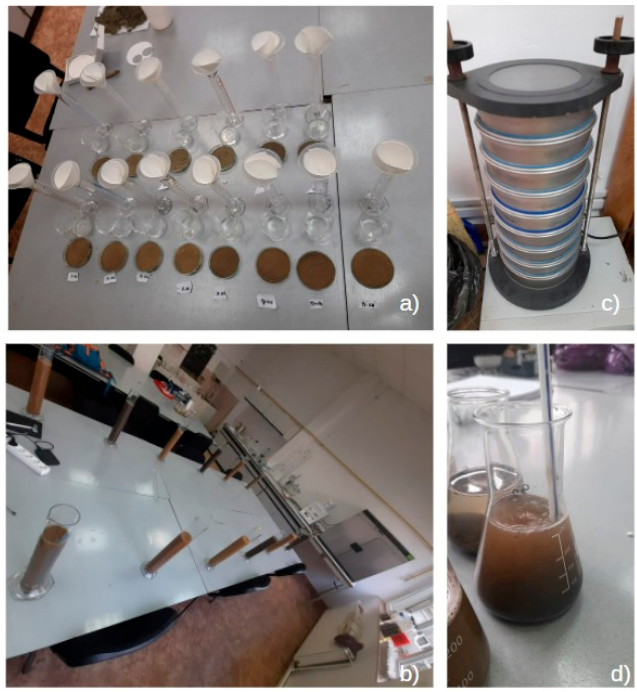
Figure 4. Soil properties measurement: ( a )—water holding capacity; ( b , c )—soil texture; ( d )—phys- ico-chemical properties.